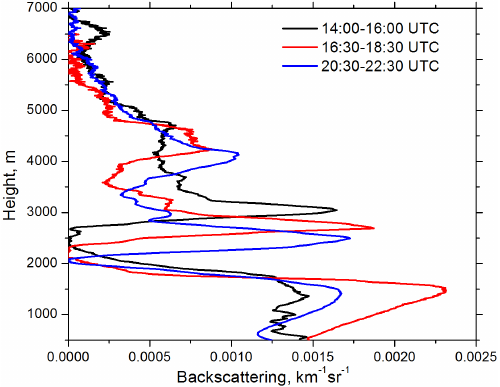
Figure 7. Vertical profiles of backscattering coefficients at 355nm on 27–28 August averaged over 23:20–01:20, 01:20-03:20 and 03:20–05:20UTC time